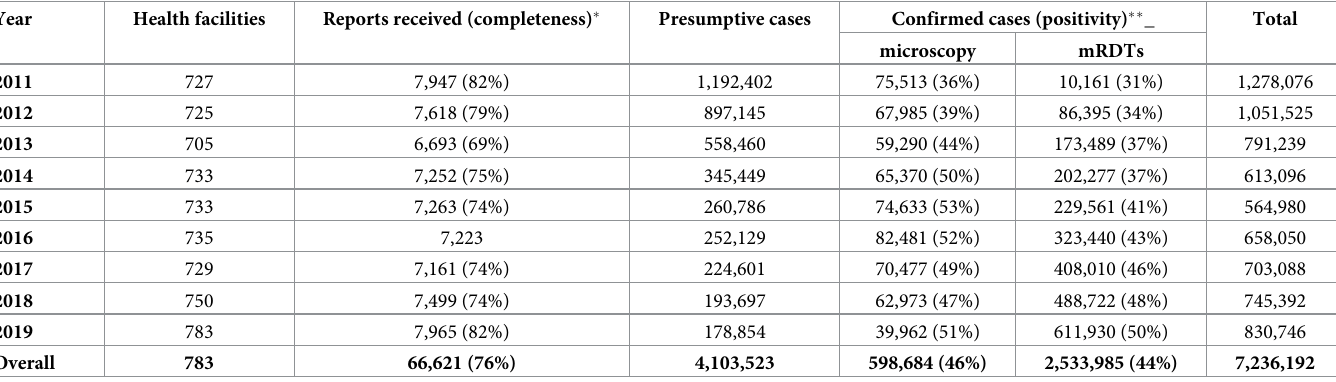
Table 1. Summary of malaria reports at health facilities, PNG